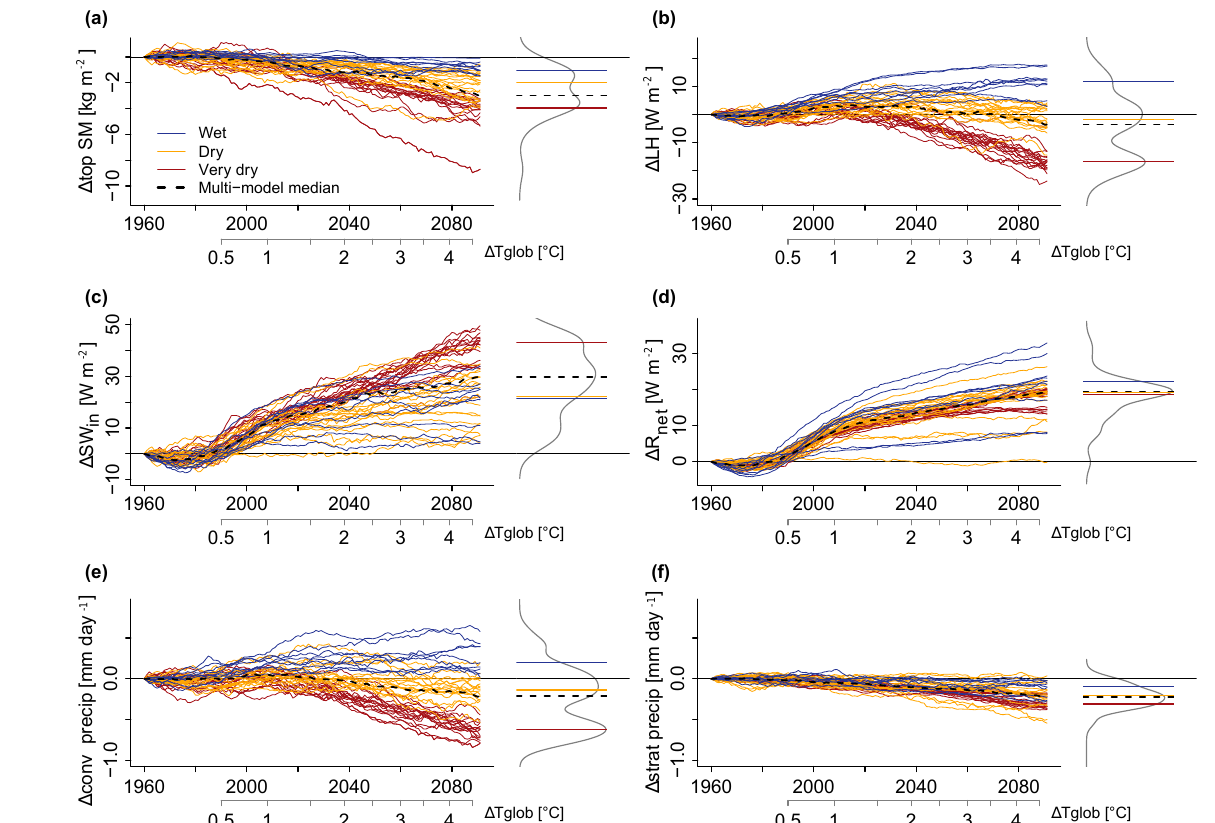
Figure 2. Change in summer (a) top soil moisture (top SM), (b) latent heat flux (LH), (c) incoming shortwave radiation (SW in ), (d) net radiation ( R net ), (e) convective precipitation (conv precip) and (f) stratiform precipitation (strat precip) in CEU for wet (blue), dry (orange) and very dry models (red), and the multi-model median (dashed). Changes are calculated as 20-year running means with respect to the base period (1950–1969). Density distributions are shown for changes between the period from 2081 to 2100 and the base